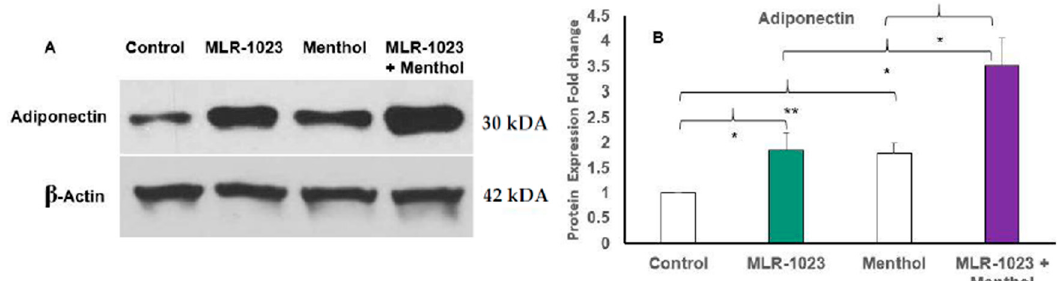
Figure 7. Immunoblotting of human adipocytes (HASCs) treated with MLR-1023 and menthol. HASCs from two obese donors were treated with MLR-1023 (30 µ M), menthol (30 µ M), and MLR-1023 in addition to menthol (30 µ M each) for seven days (four technical replicates each). ( A ) Cellular protein was extracted, and Western blot analysis was used to detect protein levels of adiponectin. ( B ) Densitometric analysis. Values are mean ± SEM. * p < 0.05. ** p < 0.01.